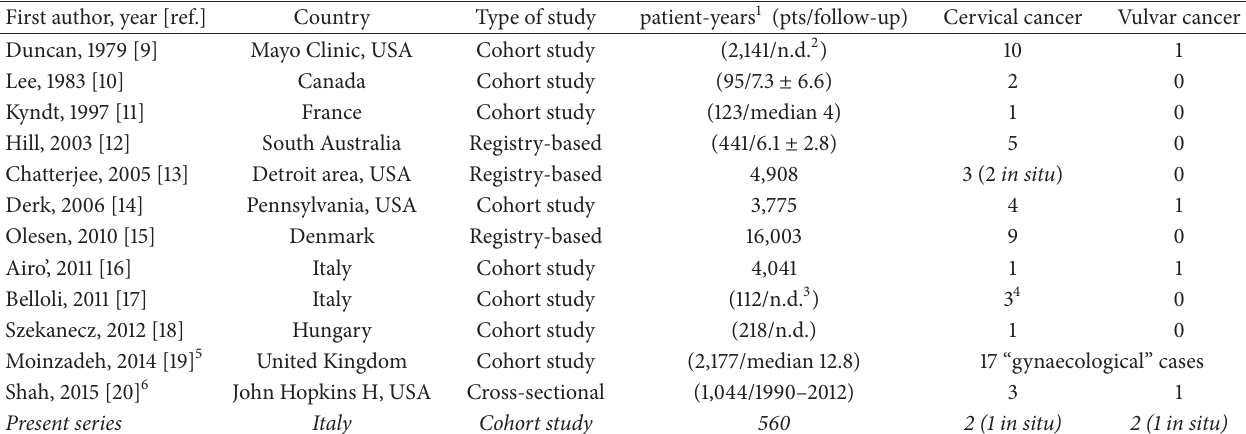
Table 2: Cervical or vulvar cancers in SSc patients: review of the